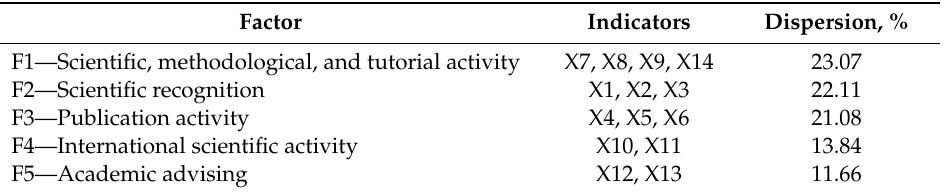
Table 4. Factors boosting scientific activities output in Russian